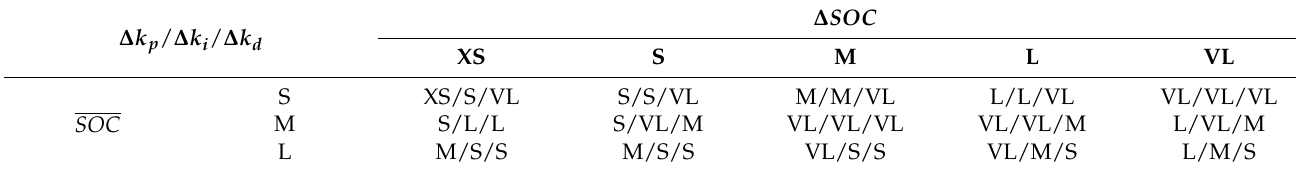
Table 2. Values for parameter adjustments ∆ k p , ∆ k i , and ∆ k d fuzzy